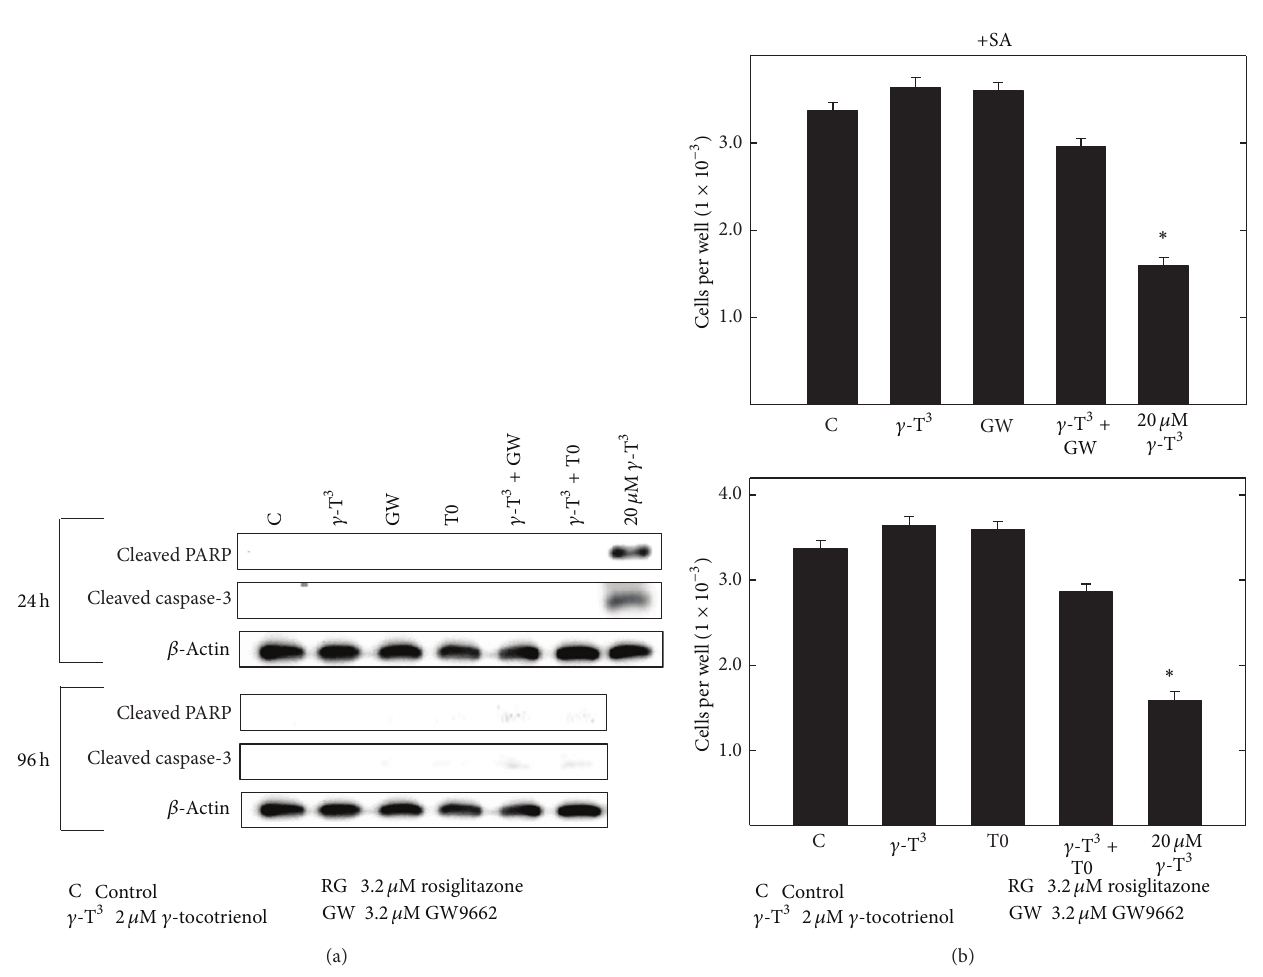
Figure12:Apoptoticeffectsof 𝛾 -tocotrienolandPPAR 𝛾 antagonistsaloneorincombinationon(a)cleavedcaspase-3,cleavedPARPlevelsand (b)viablecellnumberon+SAcells.ForWesternblotstudies,+SAcellswereinitiallyplatedat 1×1 0 6 cells/100